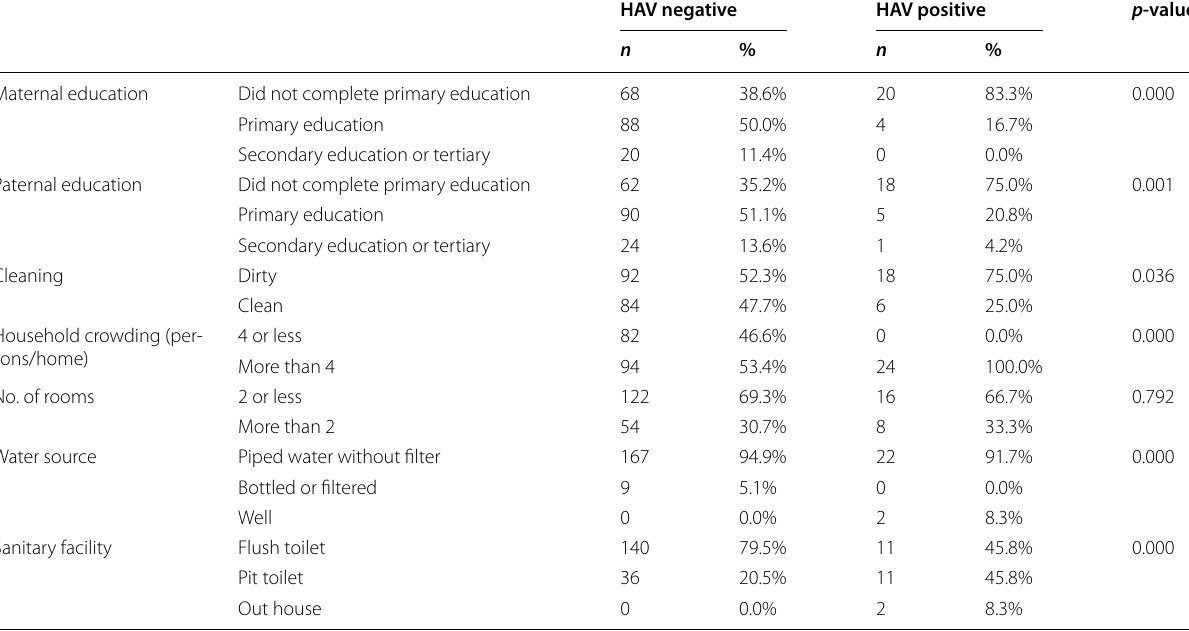
Table 2 Risk factors of HAV infection among HAV‑negative and HAV‑positive